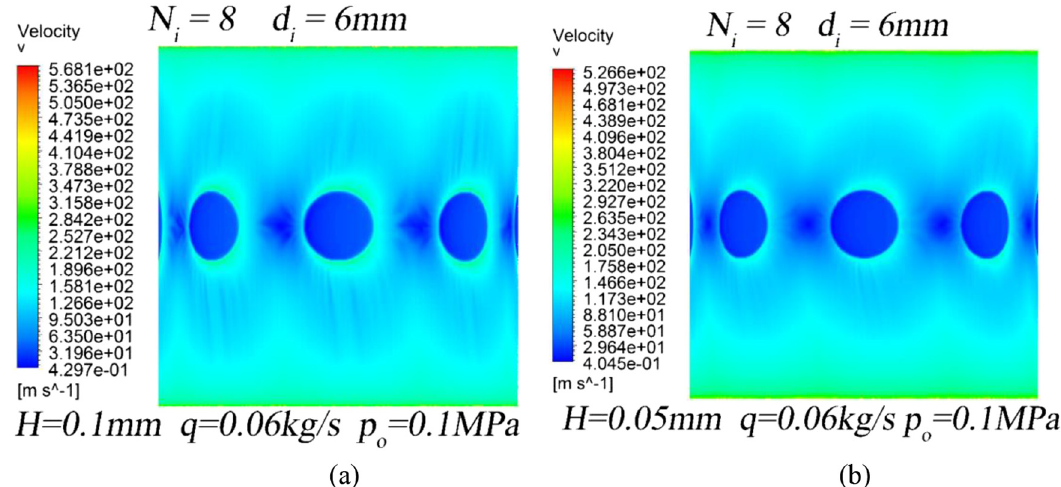
Fig. 14. Comparison of the velocity distribution between H=0.1mm and H=0.05 mm. (a) H=0.1 mm. (b) H=0.05 mm.